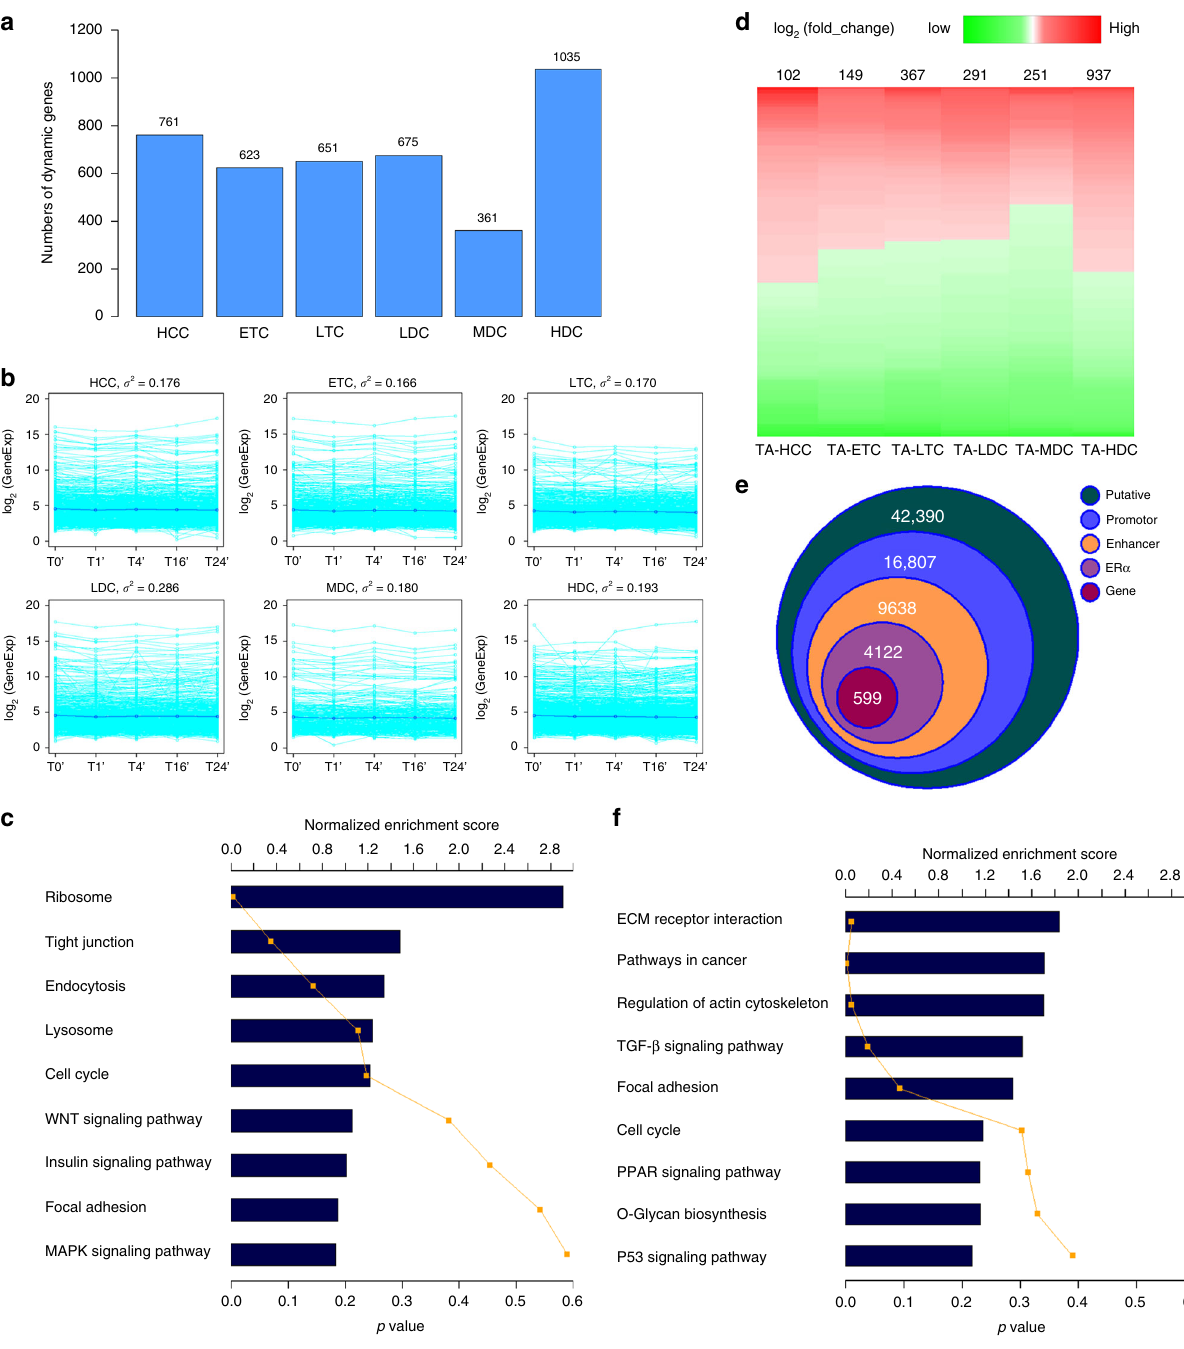
Fig. 6 Gene expression and looping in E2-induced TDRCs and TRACs. a The number of DDEGs located in each of six types of TDRCs. b A plot of gene expression values along fi ve time points in each of six types of TDRCs. Each green line represents one gene, and blue line represents the average gene expression value. σ 2 is the variance of log 2 values of gene expression. c The enrichment of KEGG pathways of 1396 genes in MDC/HDCs. d The heatmap of DEGs of TamR vs. MCF7 in each of six types of TRACs. e The number of loops de fi ned by HOMER. Putative: putative loops identi fi ed by HOMER. Promoter: one locus of putative loops within − 5 K/ + 1 K of TSS. Enhancer: one locus of putative loops within − 5 K/ + 1 K of TSS and the other with either H3K27ac/ H3K4me1 peaks. ER α : at least one locus of loops with an ER α peak and promoter − enhancer. Gene: genes associated with ER α -PE loops showing differentially expressed at TA-MDCs and TA-HDCs. f The enrichment of KEGG pathways of 396 genes associated with 599 ER α -PE loops. TDRC temporally dynamic re-compartmentalization, TRAC tamoxifen-resistant altered compartment, DDEG dynamic differentially expressed genes, KEGG Kyoto Encyclopedia of Genes and Genomes, MDC moderately dynamic compartments, HDC highly dynamic compartments